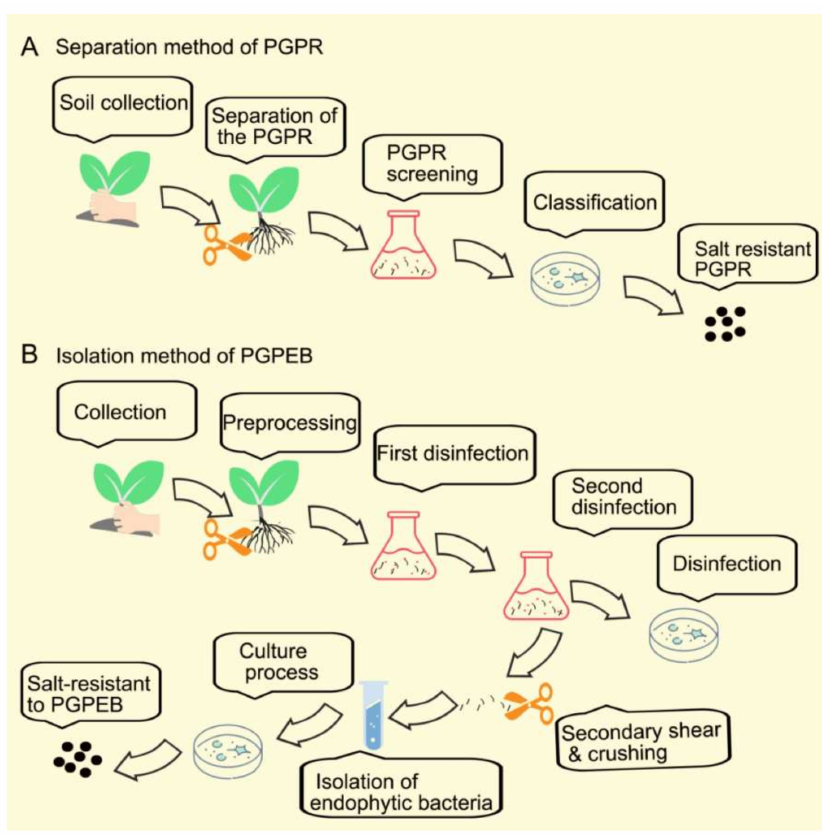
Figure 1. Isolation summary of PGPR ( A ) and PGPEB ( B